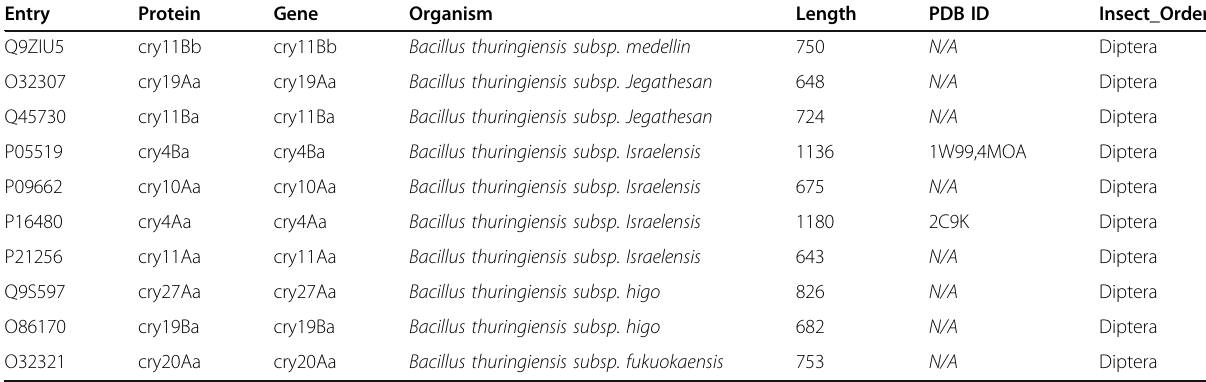
Table 2 List of cry proteins having toxicity for Diptera insect order